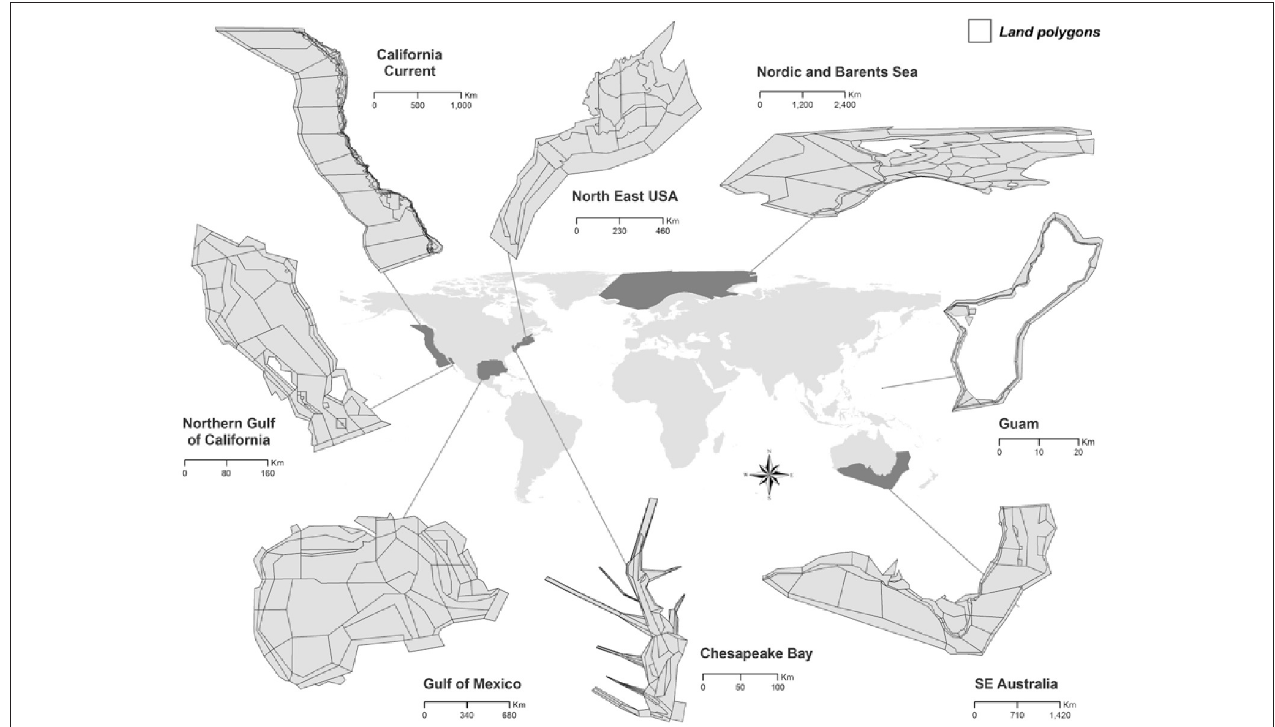
FIGURE 1 | Atlantis ecosystem model domains (see Table 1 for model